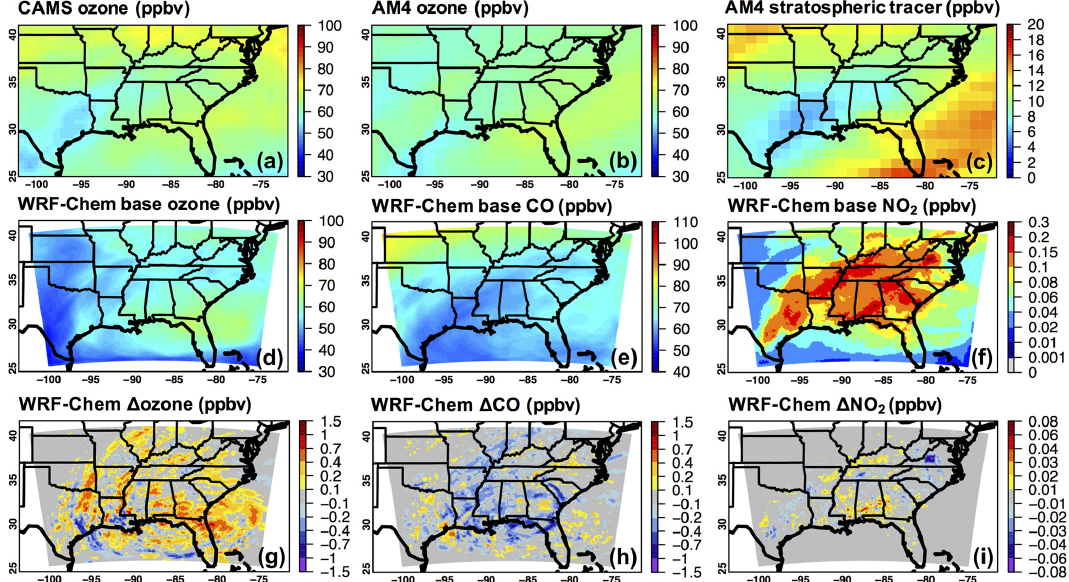
Figure 13. Period-mean (16–28 August 2016) daytime O 3 in the upper troposphere (i.e., the model levels close to 400hPa) from (a) CAMS; (b) GFDL AM4; and (d) WRF-Chem base case. Panel (g) shows the impact of the SMAP DA on WRF-Chem-modeled daytime O 3 in the upper troposphere, and panel (c) indicates the stratospheric influences on O 3 at these altitudes based on the AM4 stratospheric O 3 tracer output. Period-mean daytime CO and NO 2 from WRF-Chem base case as well as their responses to the SMAP DA are shown in (e, h) and (f, i) ,